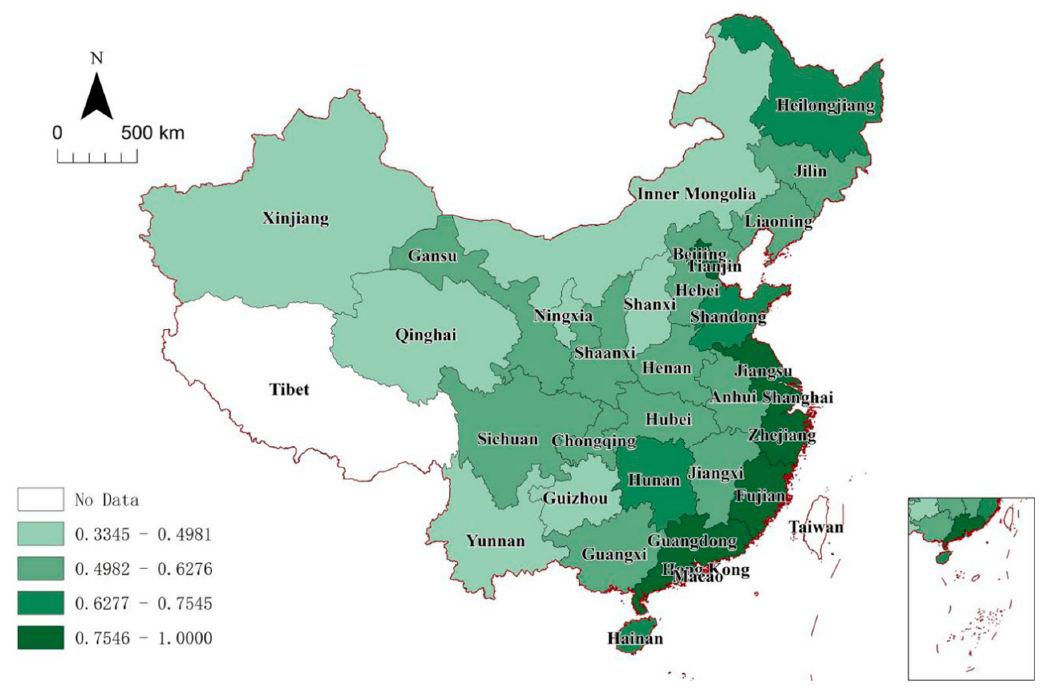
Figure 1. The schematic diagram of carbon emission efficiency intervals in 30 provinces of China.